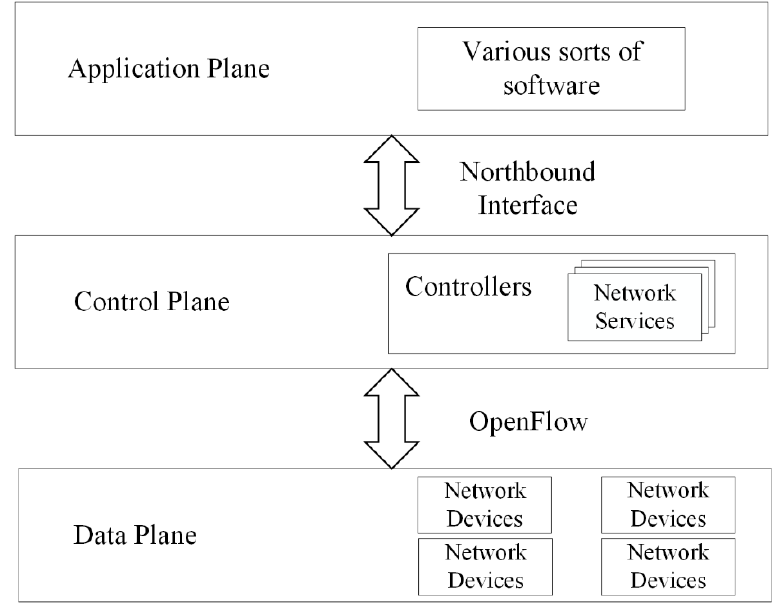
Fig. 1 The typical logical SDN